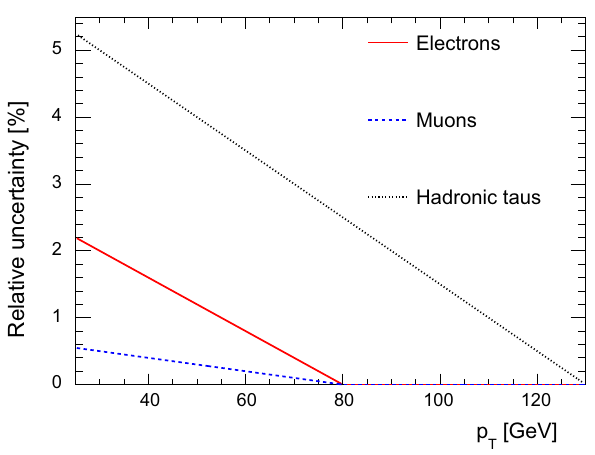
Fig. 2 The p T -dependent systematic uncertainties on the efficiencies we assume for the reconstruction, identification, and isolation criteria for prompt e ,μ , and τ had candidates